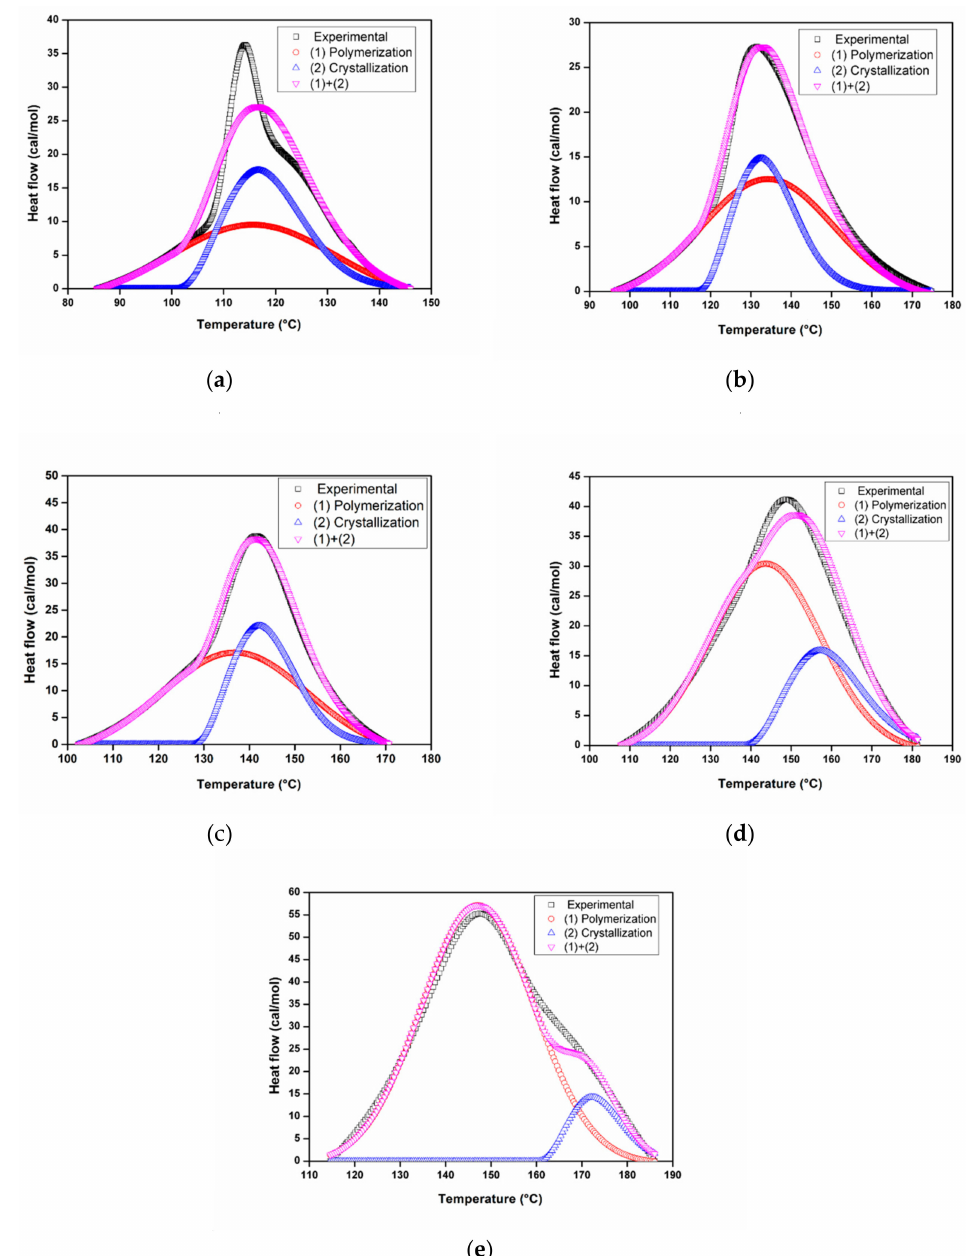
Figure 10. Separation of the polymerization and crystallization curves at di ff erent heating rates: